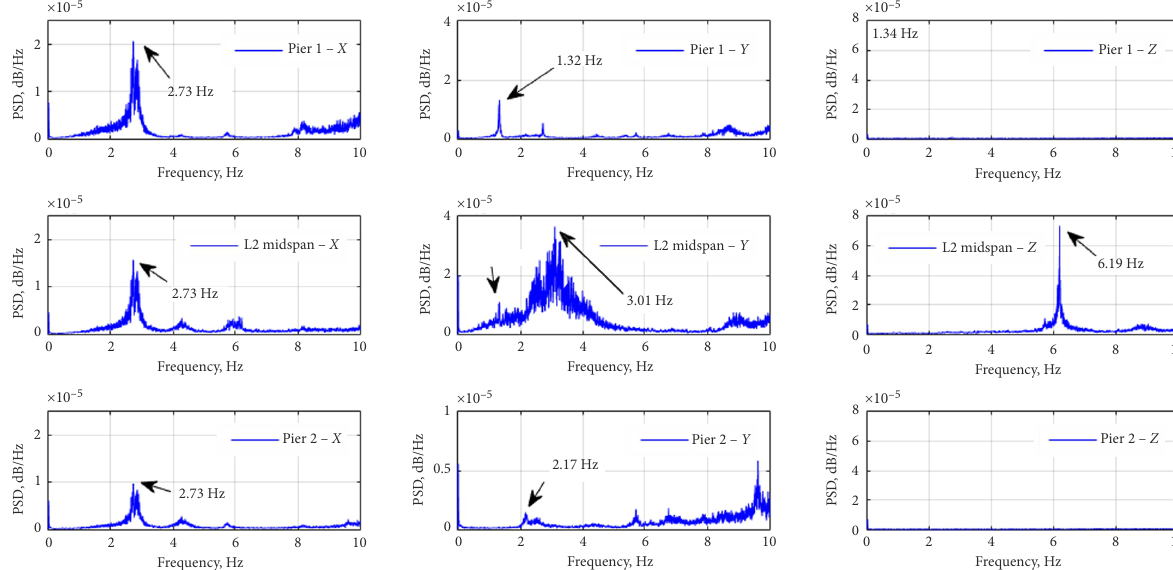
Figure 6. Frequency domain presentation of the signals for the second set of measurements in the first Ambient Vibration Survey